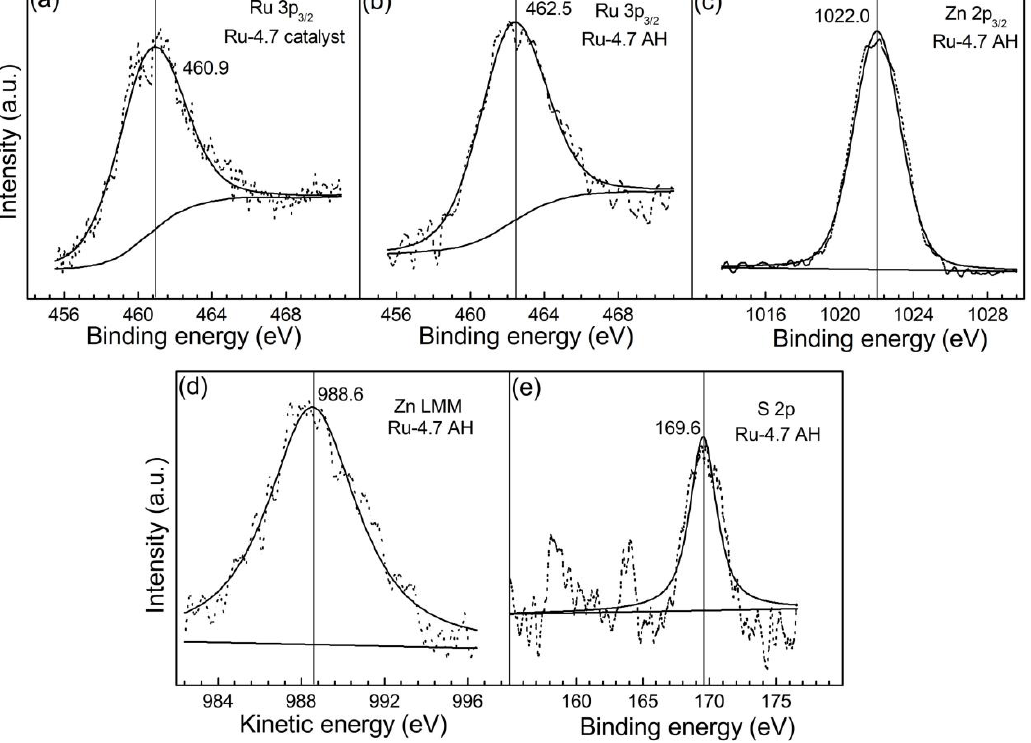
Figure 5. XPS spectra of the Ru catalyst with a particle size of 4.7 nm before and after catalytic experiments. ( a ) binding energy of Ru 3p 3/2 for Ru-4.7 catalyst; ( b ) binding energy of Ru 3p 3/2 for Ru-4.7 AH; ( c ) binding energy of Zn 2p 3/2 for Ru-4.7 AH; ( d ) Auger electron kinetic energy of Zn LMM for Ru-4.7 AH; ( e ) binding energy of S 2p for Ru-4.7 AH.